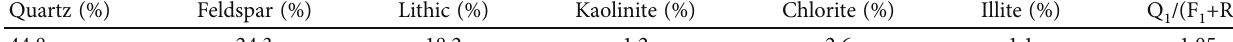
Table 1: Mineral composition and content of core samples from the Chang 6 Quartz (%) Feldspar (%)